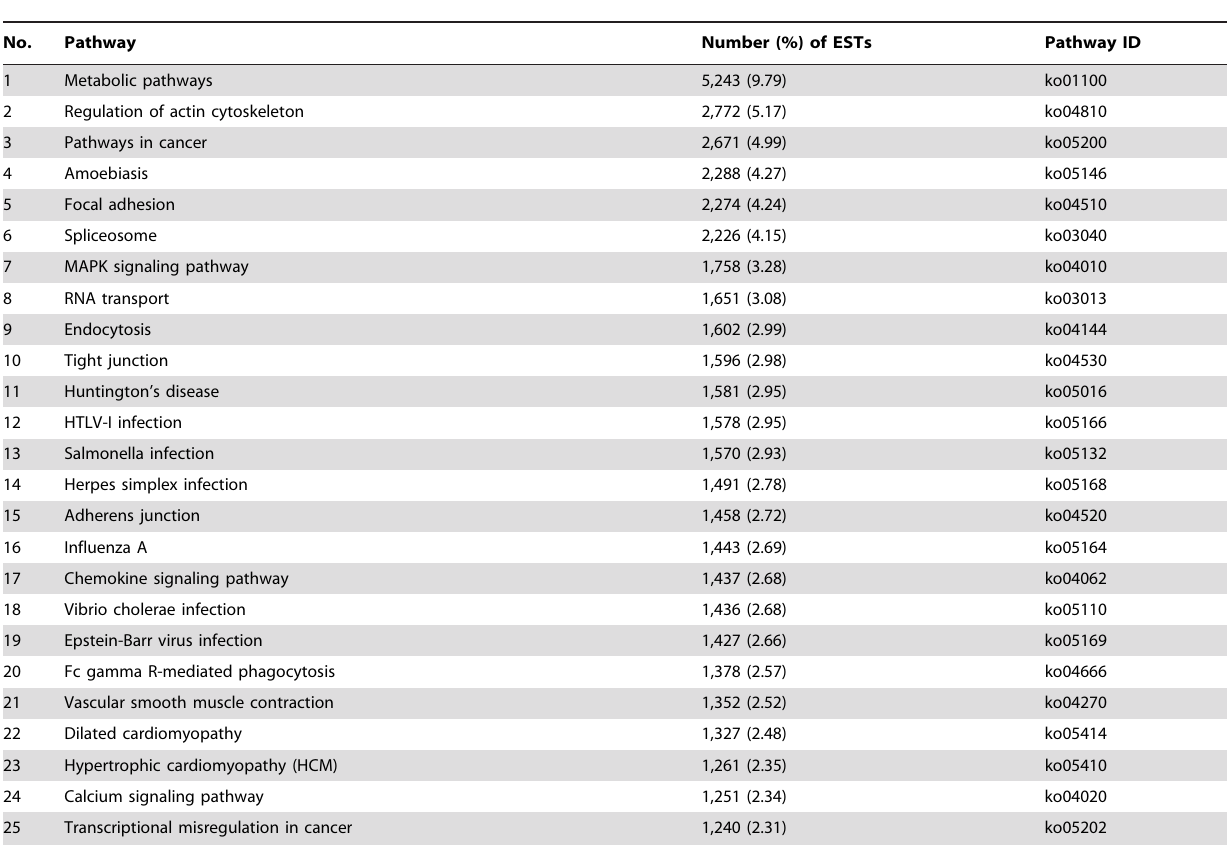
Table 2. List of the top 25 KEGG metabolic pathways identified in the Coilia nasus transcriptomes.